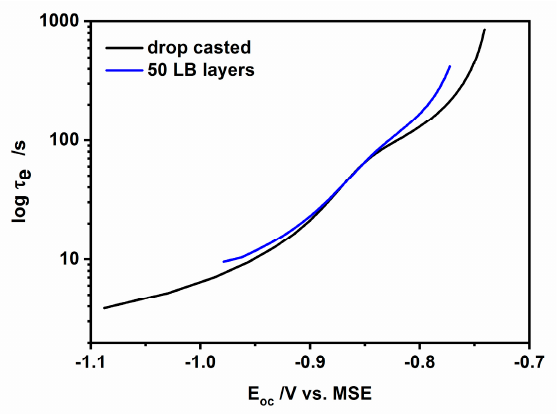
Figure 12. Representation of the electron lifetime in CdS nanoparticles deposited on ITO via